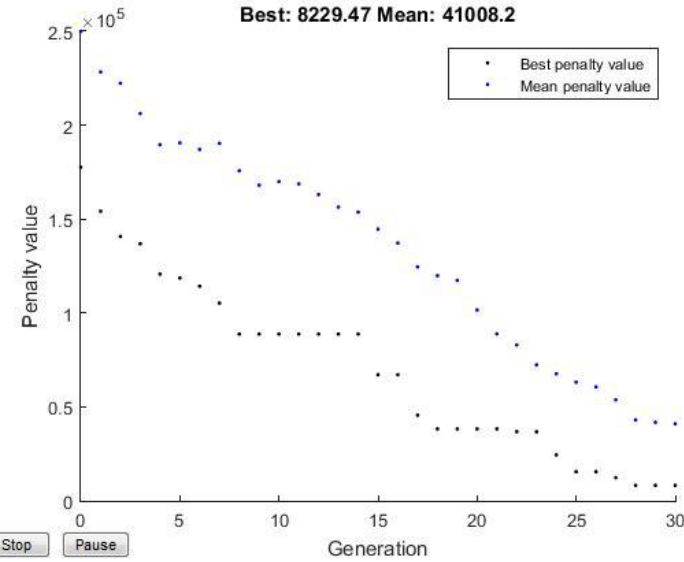
Figure 7. Running result of the GA-based method.